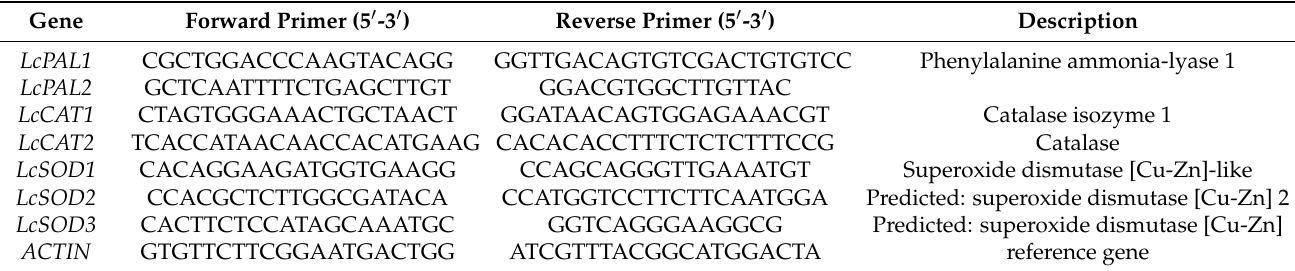
Table 1. Primers used for gene expression analysis by